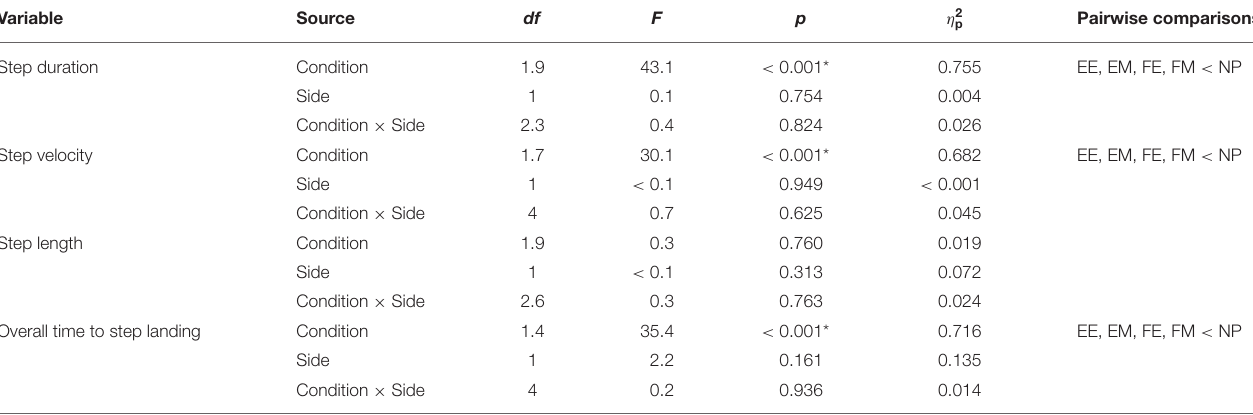
TABLE 2 | Two-way ANOVA summary table for step-execution characteristics.